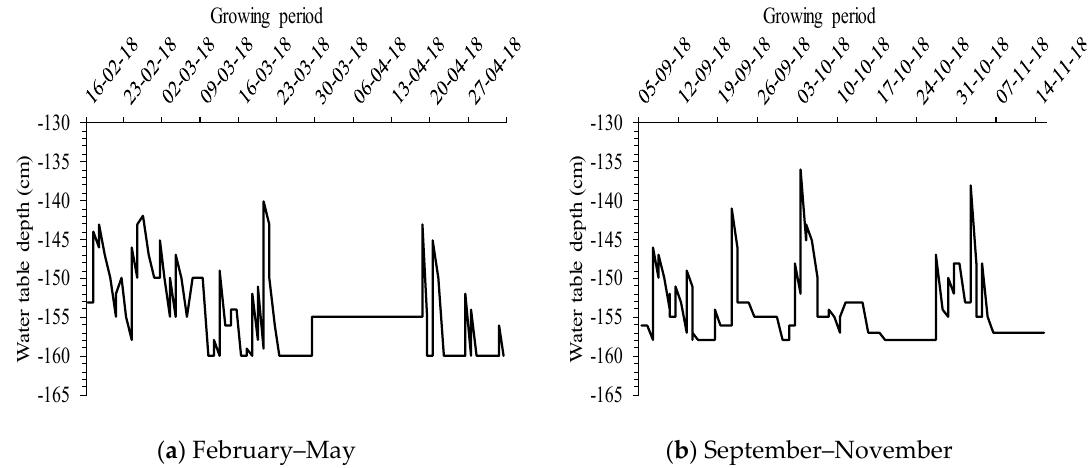
Figure 3. Comparison of observed water table fluctuation during the ( a ) first season and ( b ) second season of 2018.